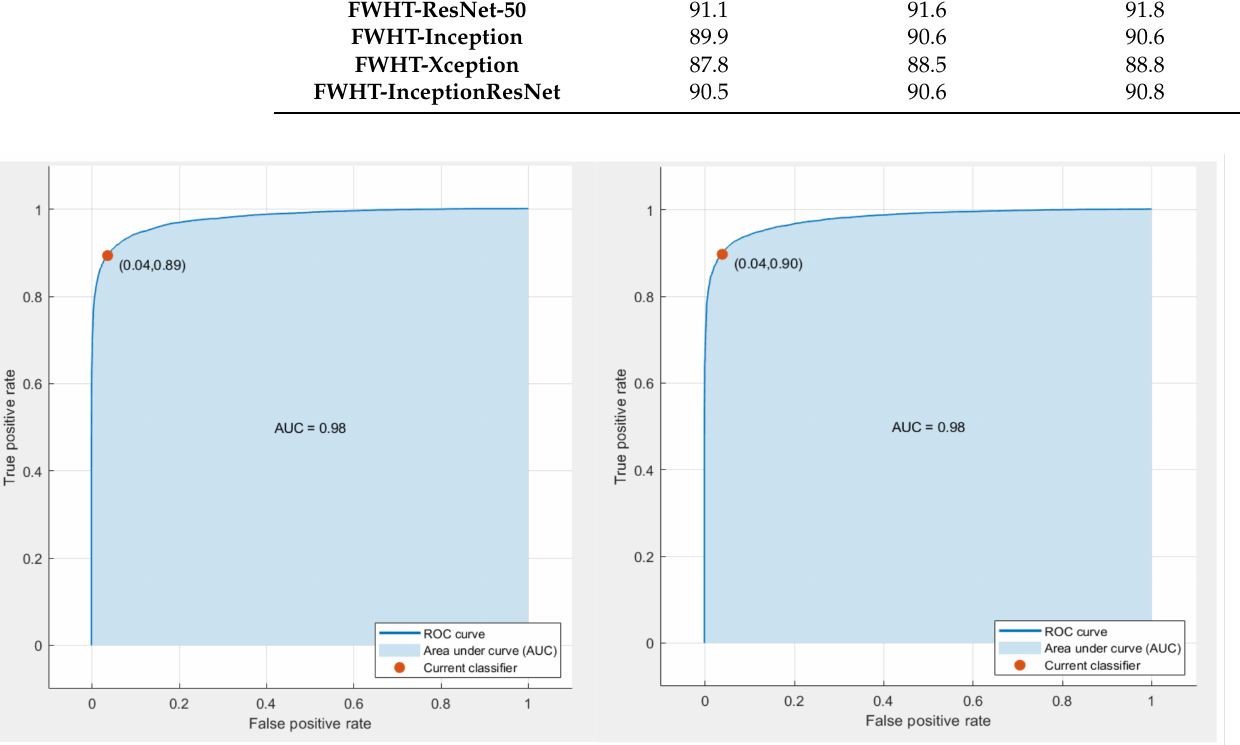
Figure 4. ROC curve analysis and AUC for ( Left ), L-SVM, ( Right ) Q-SVM trained with the spatial-spectral features involving ResNet50+Inception+InceptionResNet integrated using